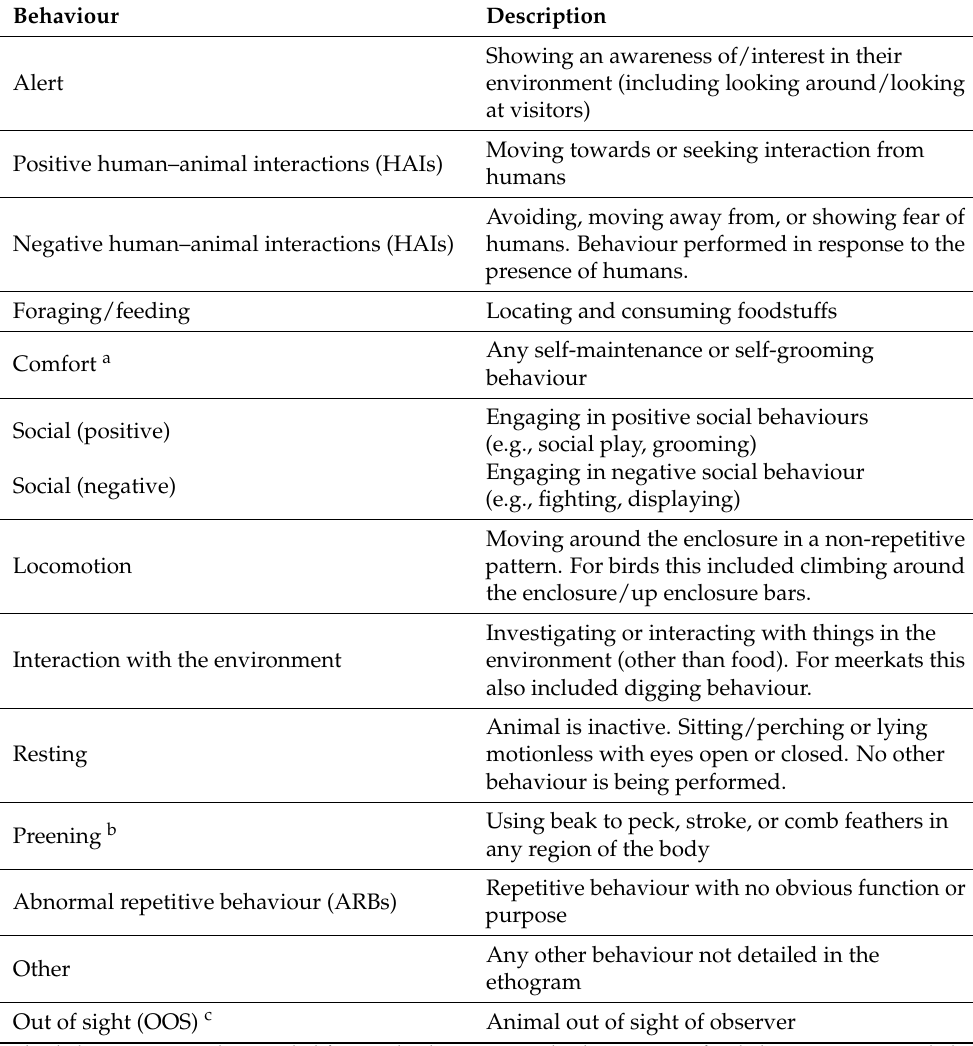
Table 3. Ethogram of behaviours for study animals during the study period